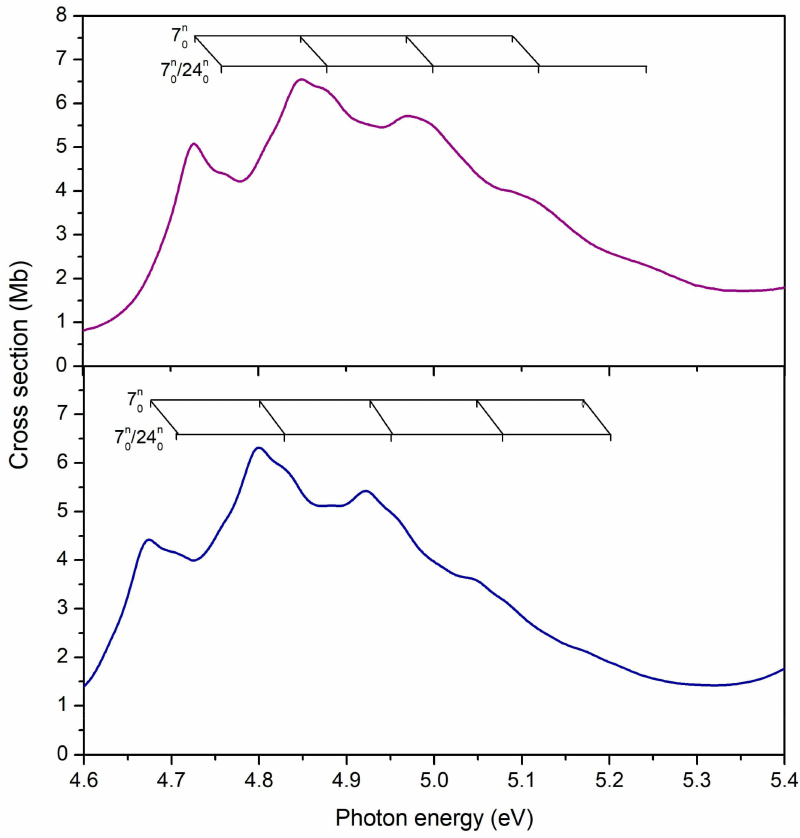
Figure 9. Vibrational progressions in the 4.6–5.4 eV energy range of the absorption Band II of 2-bromopyrimidine ( top panel) and 5-bromopyrimidine ( bottom